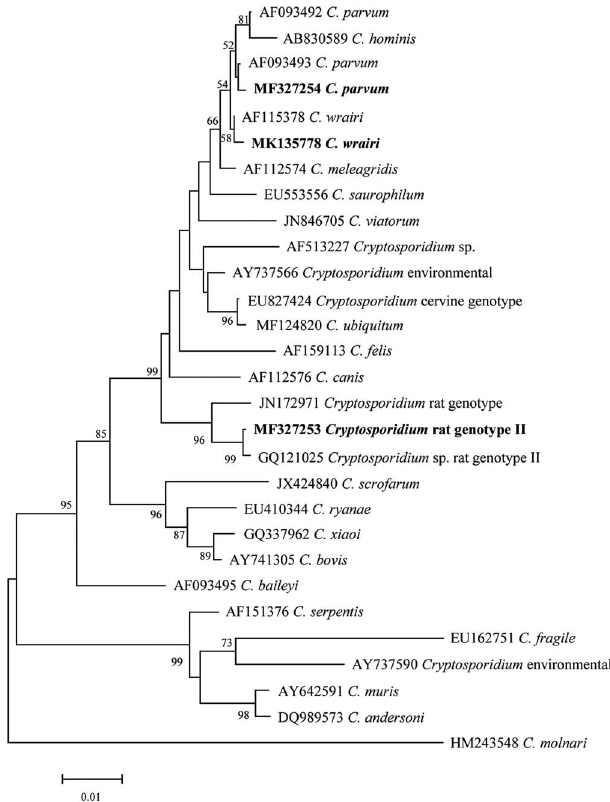
Figure 1. Phylogenetic relationship of Cryptosporidium red-bellied tree squirrel isolates in this study to other known Cryptosporidium species inferred by neighbor-joining analysis of the 18S rRNA gene based on evolutionary distances calculated using the Kimura 2- parameter model. Bootstrap values were obtained using 1000 pseudo-replicates, with only values above 50%